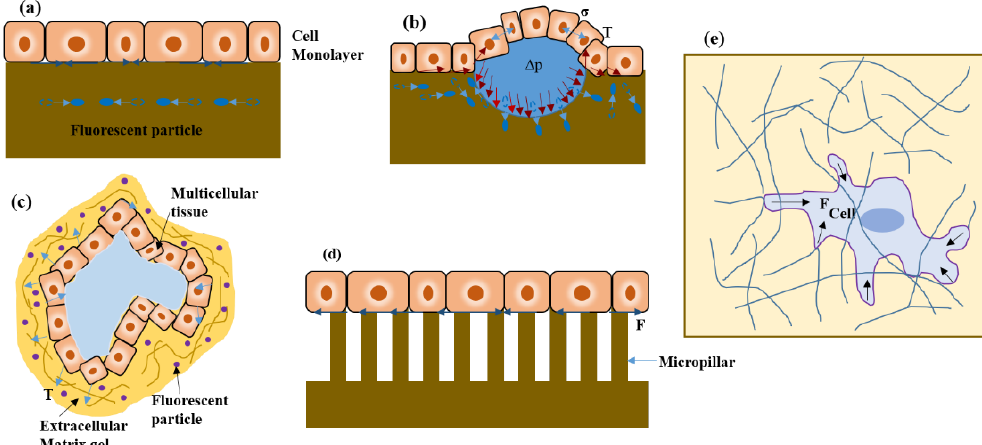
Figure 4. Measurement of cell generated forces. ( a ) Schematic of the principles of 2D traction force microscopy (TFM). Cells or tissue can attach to the surface of a flat elastic gel. Tractions are exerted by the cells on the substrate, and fluorescent particles in or on the substrate are imaged using various microscopy methods, typically, confocal microscopy. The resulting deformation is tracked by comparing the position of the particles with an image of the substrate at rest (that is, after complete removal of adhered cells). Using different computational and analytical approaches, tractions are calculated. ( b ) Schematic of 2.5D TFM. In this technique, cells or tissue are seeded on top of a 2D elastic substrate. The substrate displacements (detected as changes in the position of the blue particles embedded in the substrate, typically by confocal microscopy) are measured in 3D. For simple geometries, such as spherical caps, the internal stresses of the tissue can be recovered with a micro bulge test. ( c ) Schematic of 3D TFM. The 3D displacement field (blue arrows) for tissues grown inside a deformable ECM gel can be measured by detecting changes in the position of matrix-embedded particle tracers using confocal microscopy. (T—The force per unit area acting on any internal or external surface of a material is called the traction vector T) ( d ) Schematic of the micropillar-array technique. Cells are seeded on top of an array of micropillars. The deflection of these pillars is proportional to the locally applied force. (Figure redrawn from [29]). ( e ) In 3D ECM, cellular tractions are distributed throughout the 3D space, and traction forces propagated along ECM fibers cause remodeling of the ECM, altering local mechanical properties. (F—Force exerted by the cell on the environment) (Figure redrawn from